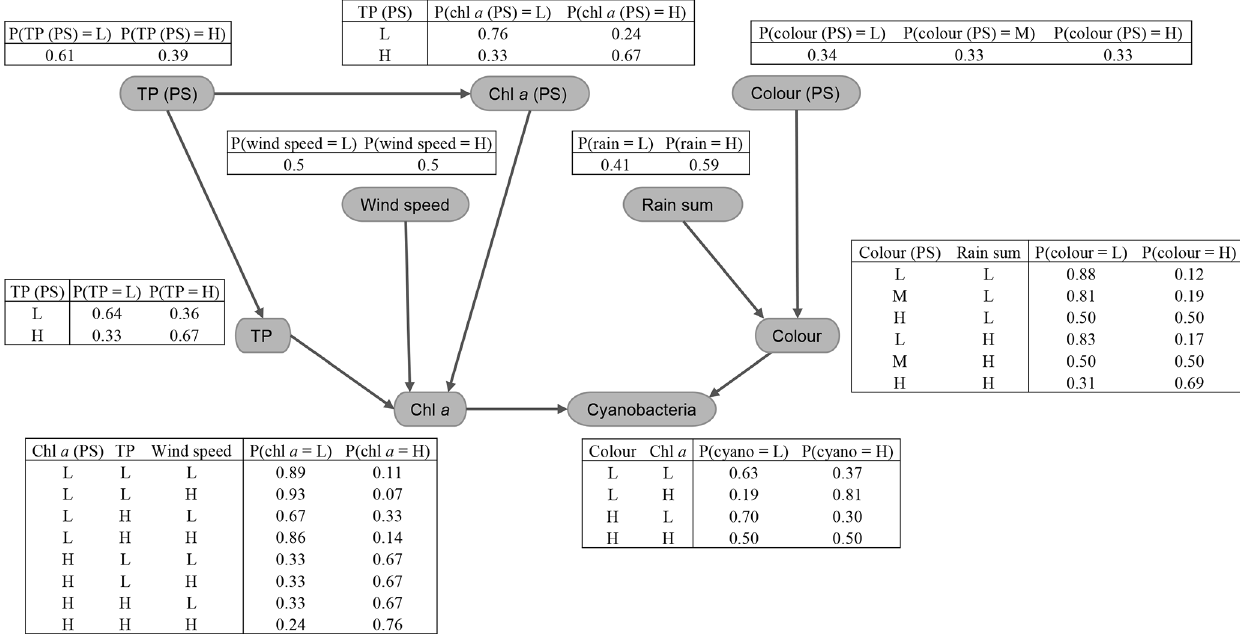
Figure 7. Gaussian Bayesian network (GBN) structure and parameters defining the conditional probability densities at each node. Units for standard deviations ( σ ) and intercepts ( β 0 ) are the same as the original data, aside from cyanobacteria, where a Box–Cox transformation was used ( λ = 0 . 1). See Table 1 for a detailed description of the variables and Table B1 for 95% confidence intervals on the fitted coefficients.